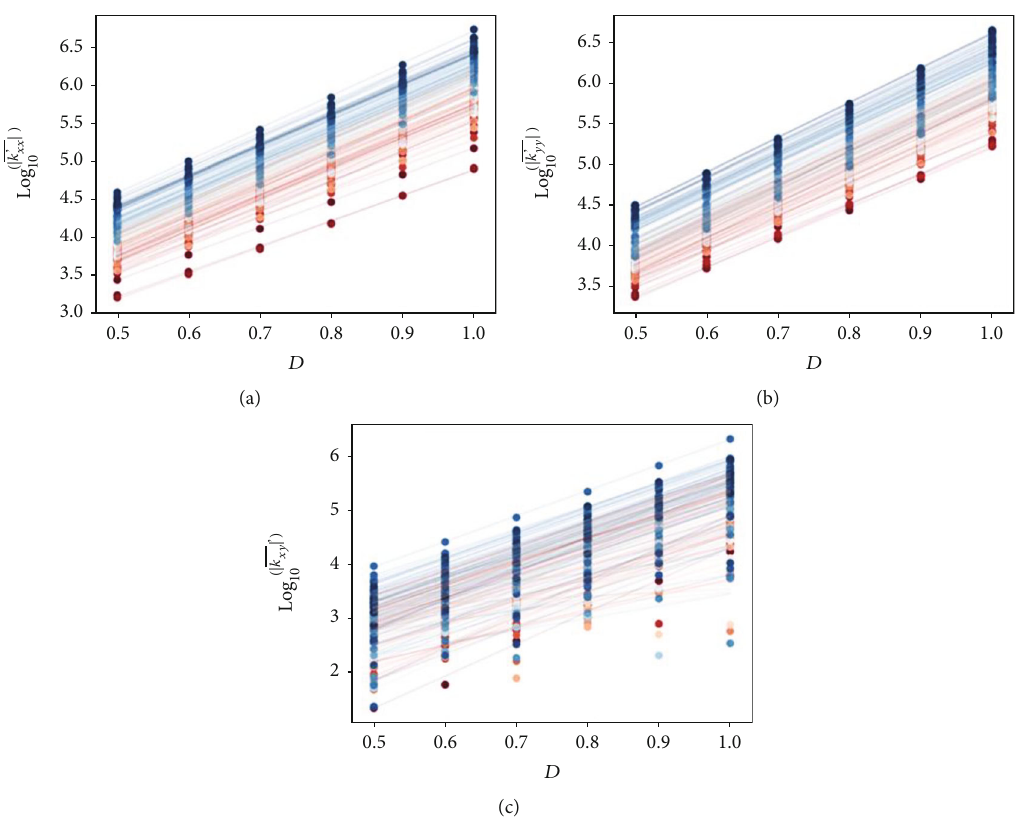
Figure 7: The average dimensionless permeability components of the equivalent fracture model versus aperture-length correlation exponent D of the discrete fracture model for increasing fracture geometric properties l